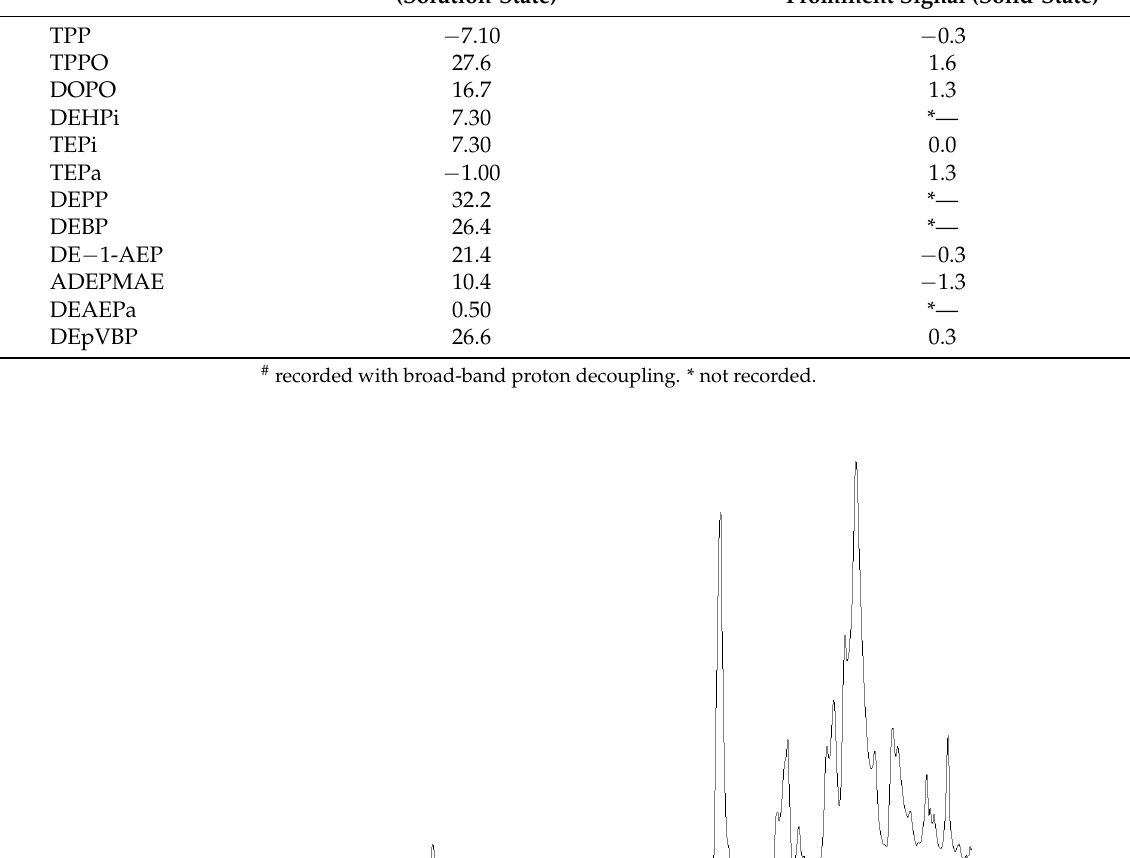
Figure 1. Solid-state 13 C-NMR spectrum of char obtained from PMMA + DE-1-AEP (the abscissa denotes the chemical shift values, δ , in ppm and the ordinate corresponds to the signal intensity in arbitrary units). Table 3. The 31 P chemical shift values ( ∂ , in ppm) of the additives/reactives and char residues of PMMA-based materials. Sl. No.